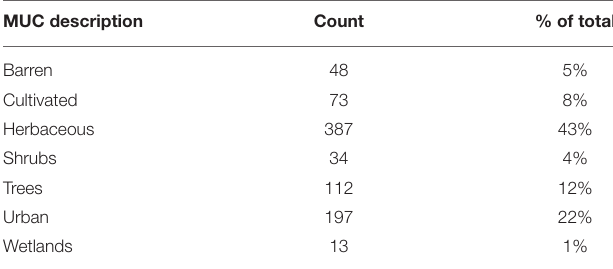
TABLE 2 | GLOBE Observer volunteer